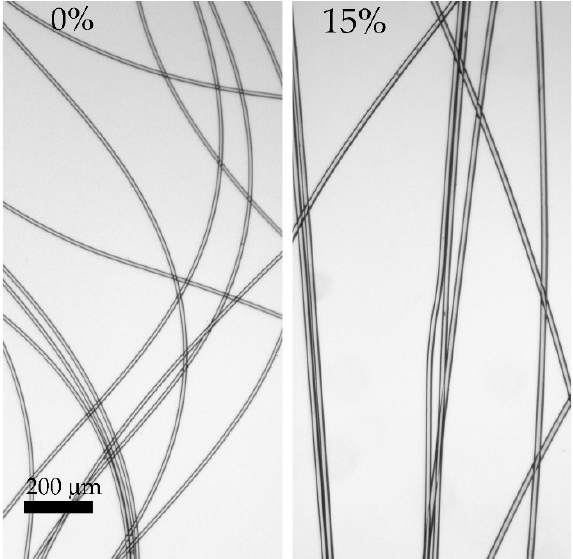
Figure 16. Images of spun fibers made by optical microscopy. Silica concentration is at the polymer weight.